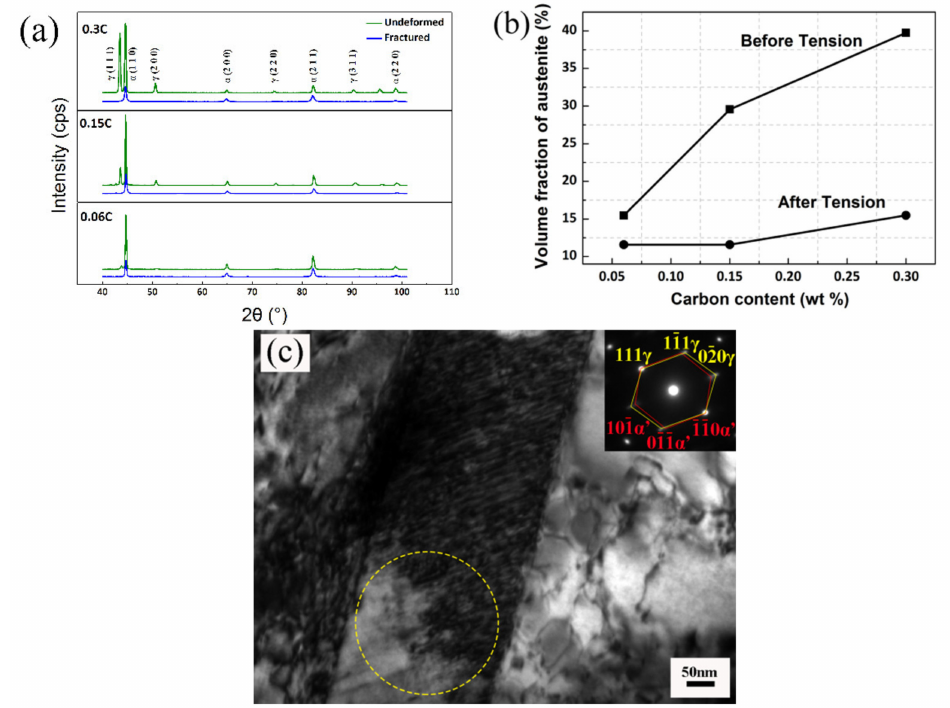
Figure 4. Volume fraction of retained austenite and Transmission Electron Microscope (TEM) image of martensite. ( a ) X-ray diffraction (XRD) patterns of the experimental steels. ( b ) Volume fraction of retained austenite before and after tensile test. ( c ) Martensite and retained austenite with Kurdjumov-Sachs (K-S) orientation relationship.